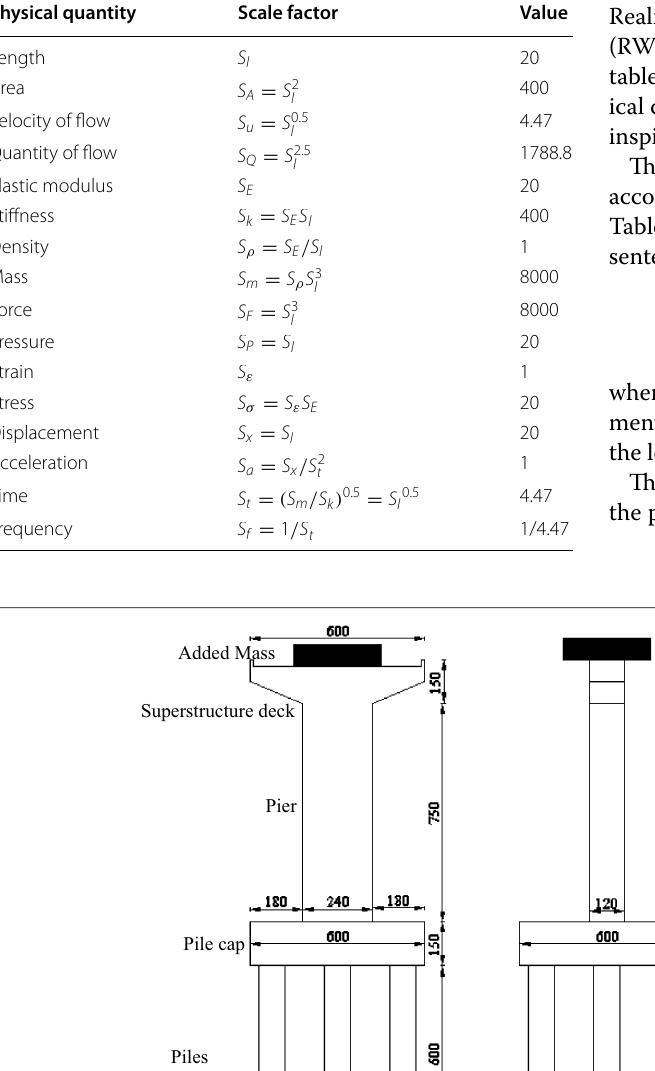
ical quantities. Fig. 2 depicts the dimensions of the model